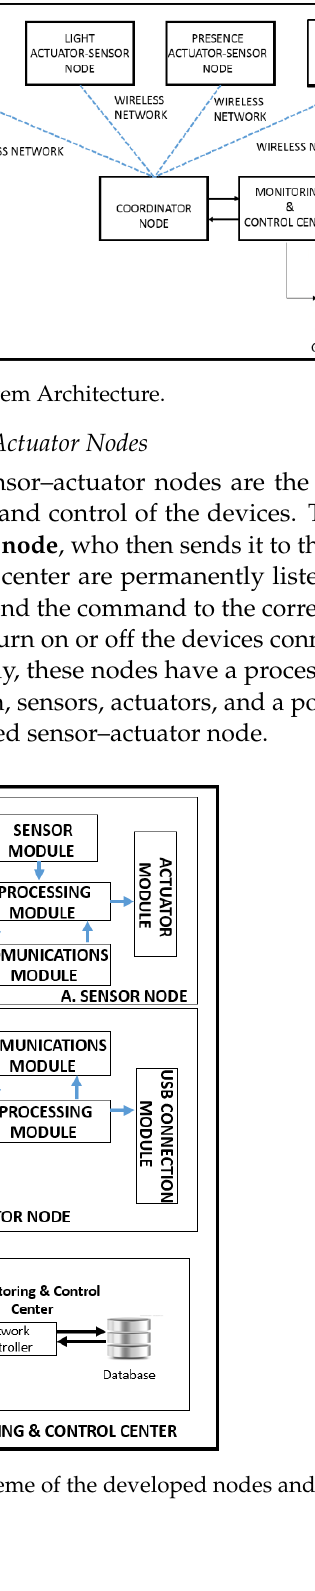
Figure 3. Scheme of the developed nodes and monitoring and control